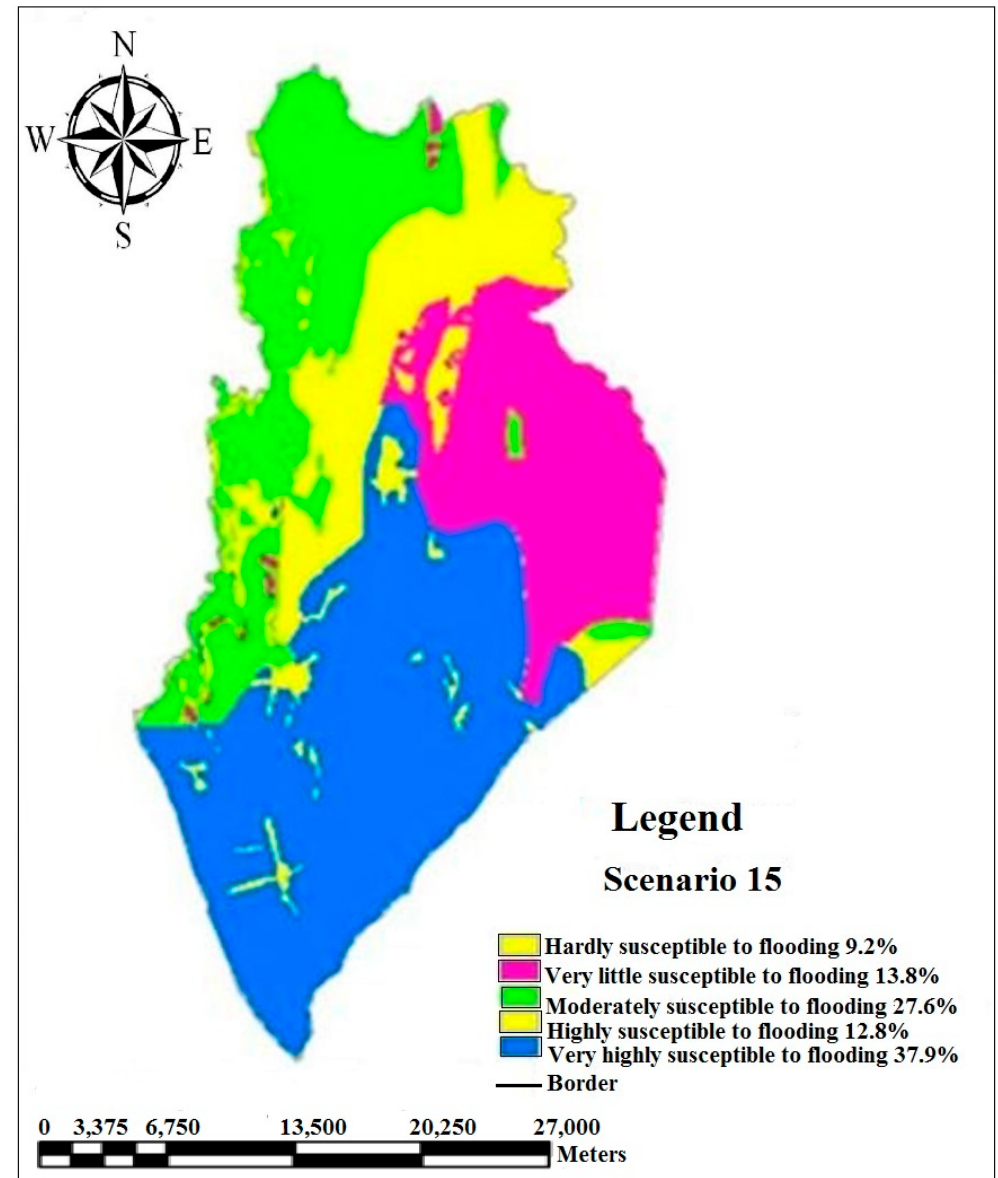
Figure A5. Importance of flat slope (Scenario 15).